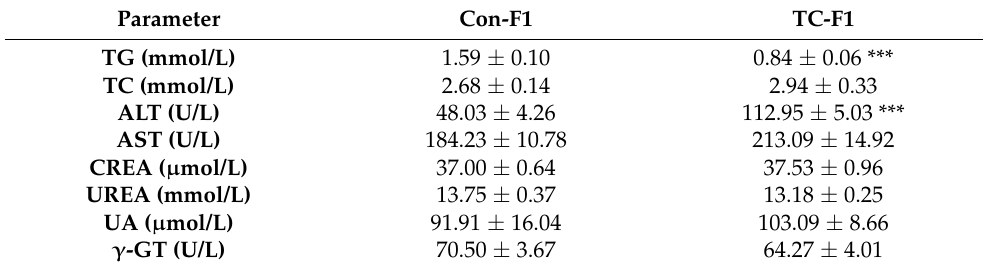
Table 1. Serum biochemical parameters.